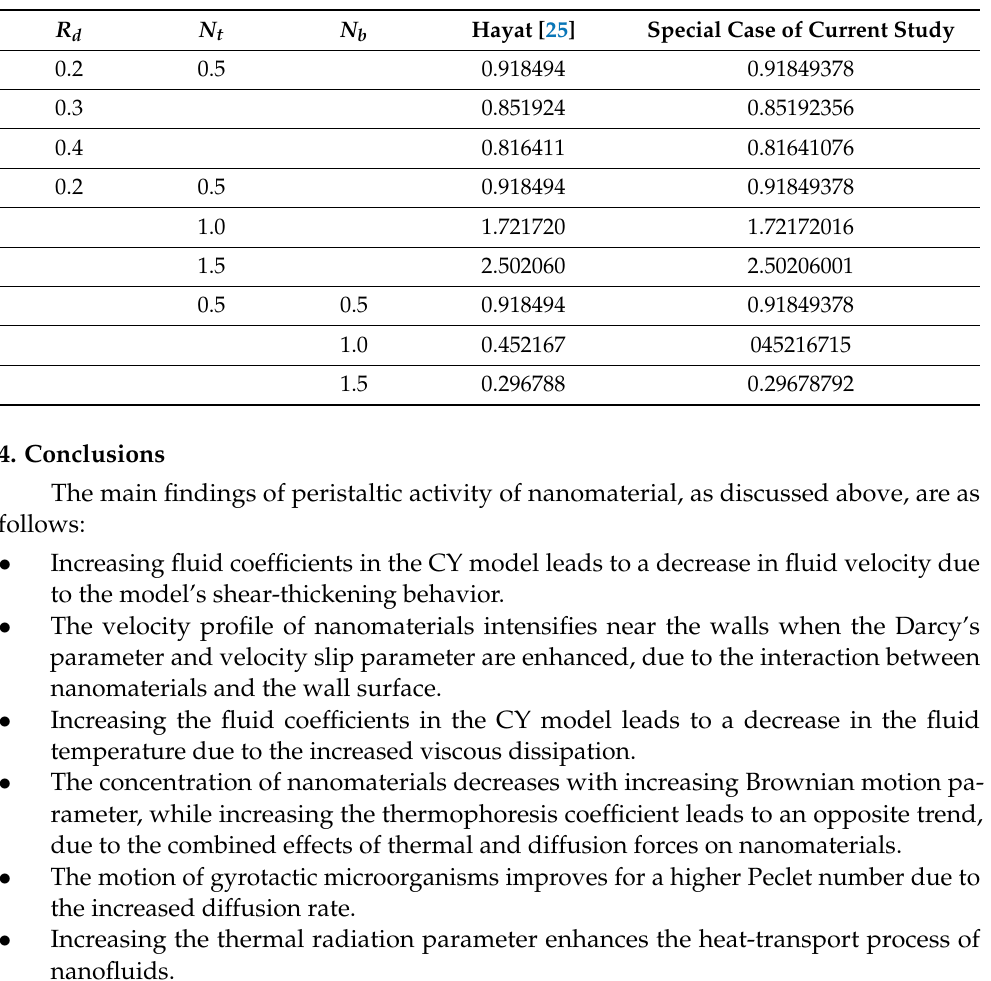
Table 2. Comparison of heat-transfer rate at the upper wall to the published work [25], when G T = G C = G N = Pe =